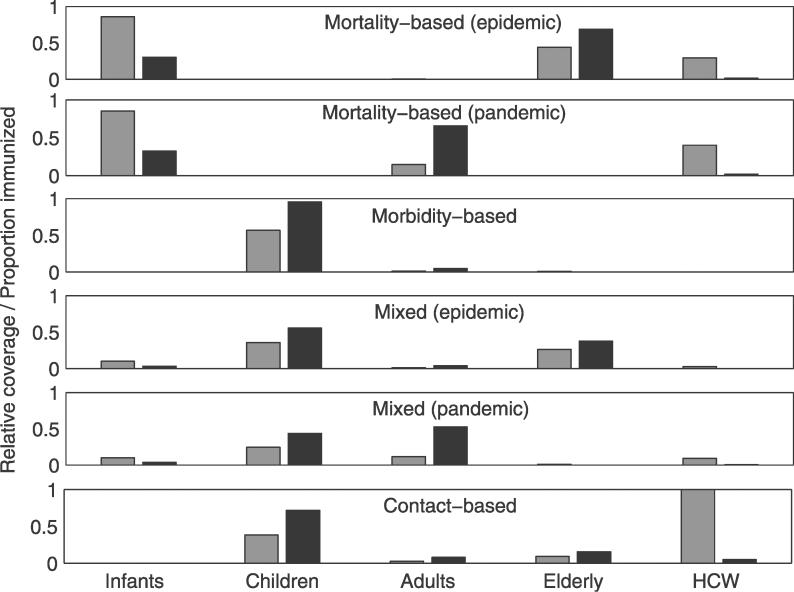
Vaccination StrategiesThe demographic distribution of vaccines according to each of the strategies: the black bars reflect the fraction of available vaccines given to each age group (and thus will always sum to one). The gray bars reflect the proportion of each demographic that is effectively immunized, and thus take into account the size of the demographic and the demographic-specific vaccine efficacy.HCW, health-care worker.